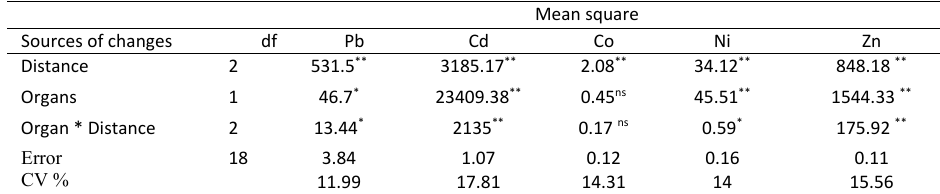
Fraxinus Table 4: The effect of distance from the highway within the bark and leaves of